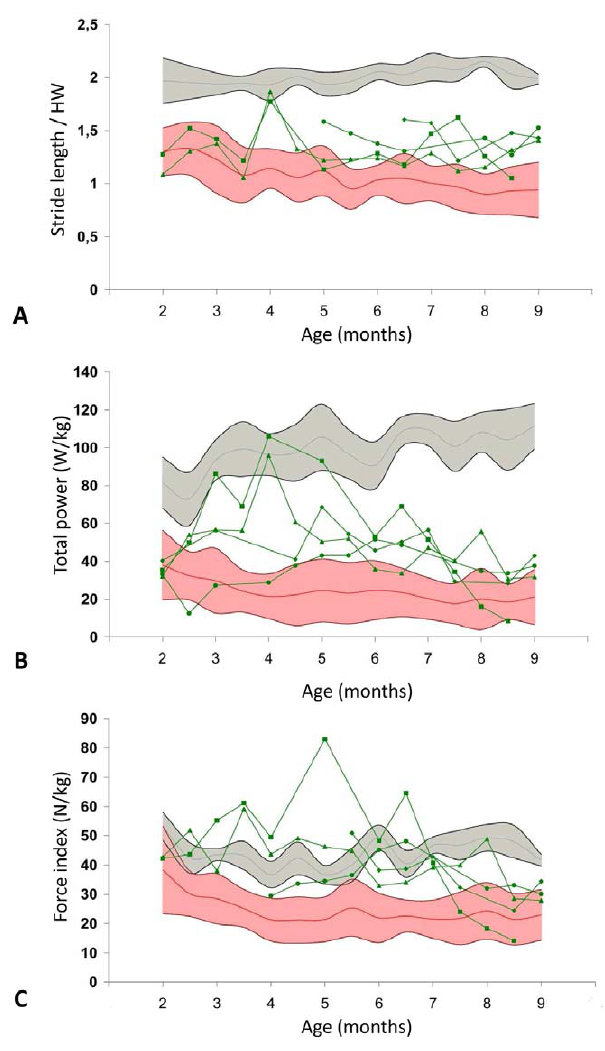
Figure 7. Evolution of three accelerometric variables during the treatment. The three graphs represent the evolution of the stride length normalized by the height at withers (A), the total power (B) and the force index (C), during the treatment. The treated dogs are represented by individual green curves, in comparison with the mean values (red curve) 6 SD (pink area) obtained in untreated GRMD dogs and the mean values (grey curve) 6 SD (grey area) obtained in healthy dogs. The improvement of the three variables during the treatment can be noticed on the graphs. These three variables become significantly improved in comparison with untreated GRMD dogs at many points between 3 and 9 months.